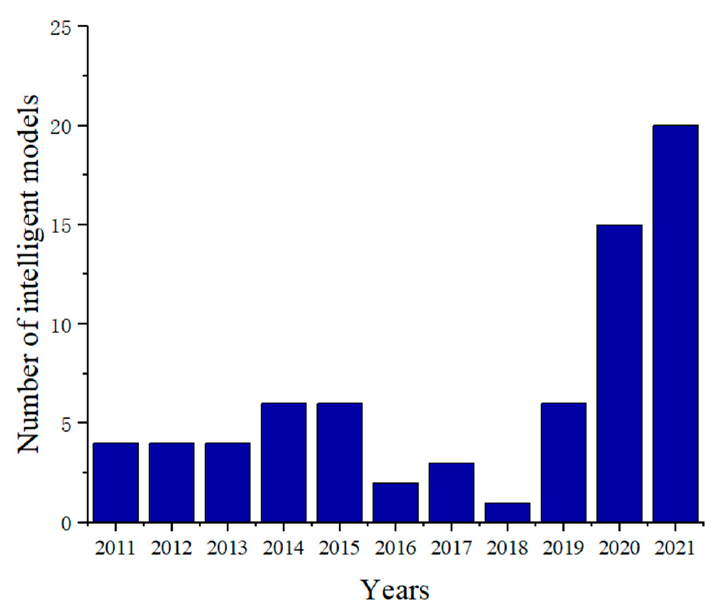
Figure 6. The number of related intelligent models from 2011 to November 2021.